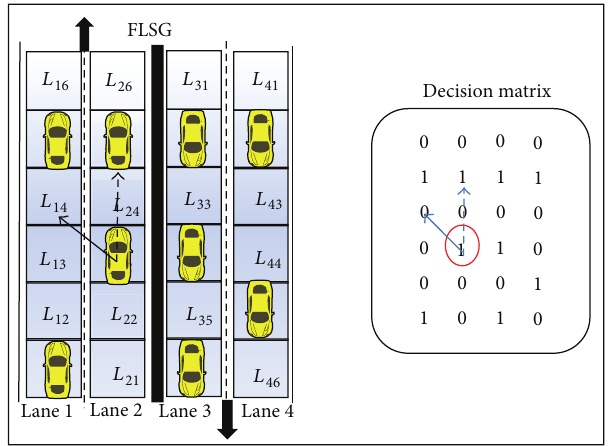
Figure 7: Scenario of abnormal deceleration with respective deci- sion matrix.